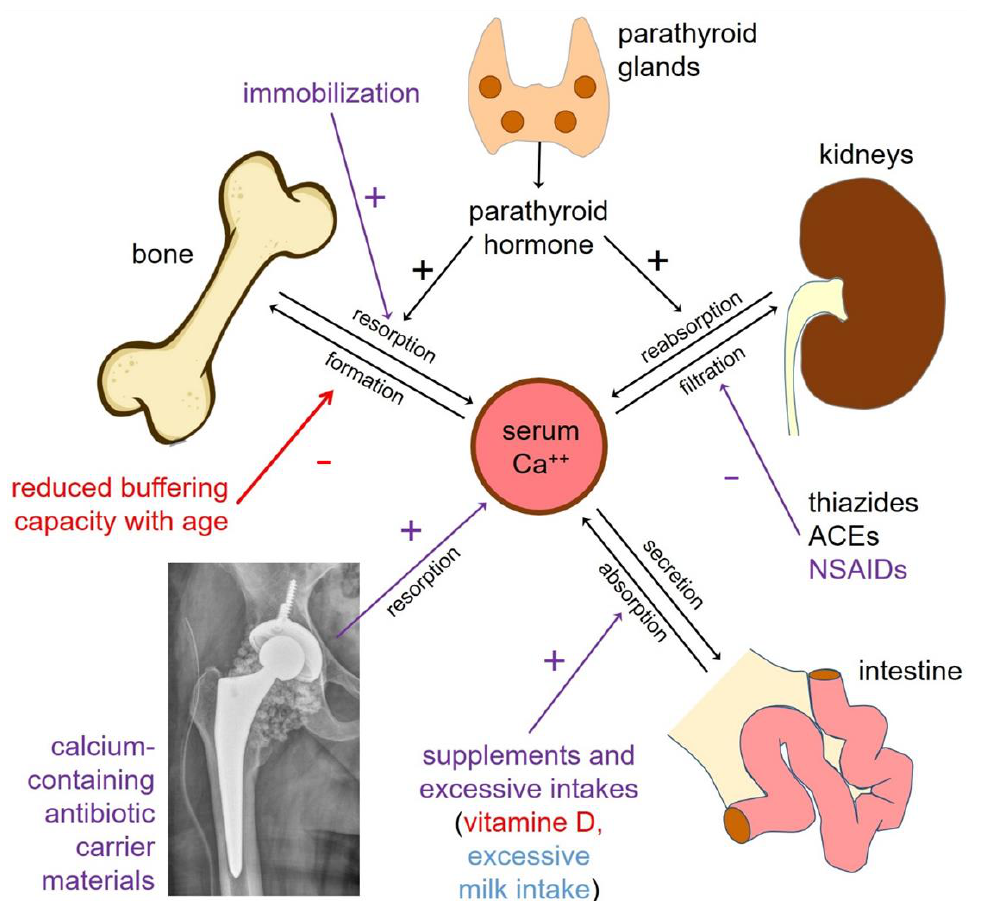
Figure 3. Overview of the pathophysiologic pathways involved in calcium homeostasis. Disturbing factors present in the two cases described are marked. Factors affecting only Case One are marked blue, those affecting only Case Two are marked red and those present in both cases are marked purple. Implanted CaSO 4 represents a large calcium burden for the patient, as calcium makes out approximately ¼ of the weight of the material. Decreased compensatory mechanism in elderly or frail patients may then be overwhelmed, particularly if any drugs cause supplementary interfer- ence.